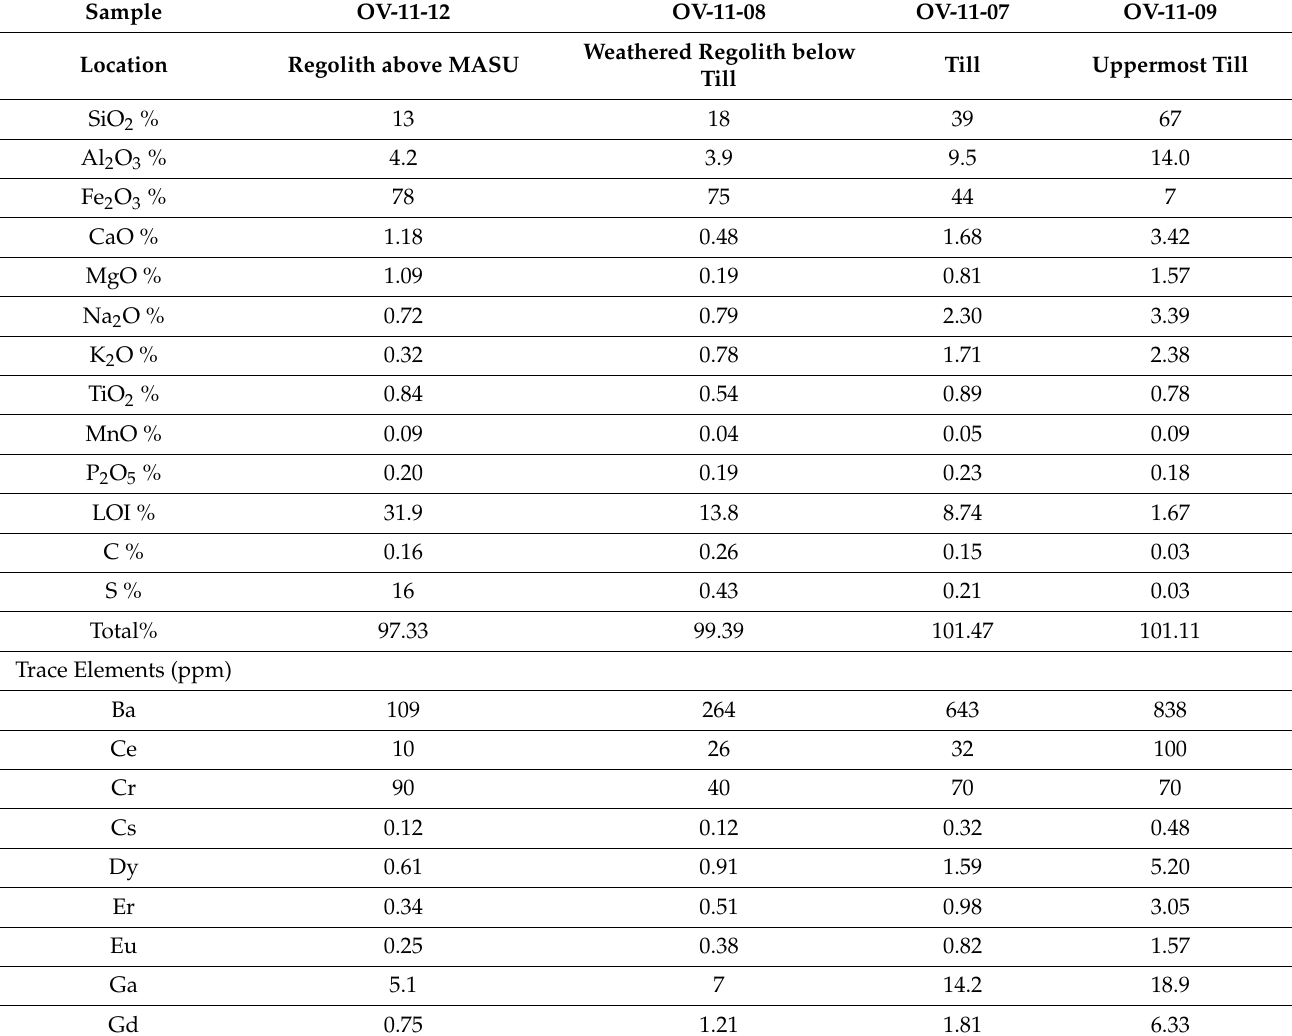
Table 4. Whole-rock geochemical data for OV-11 samples, Mini-Ovoid, Voisey’s